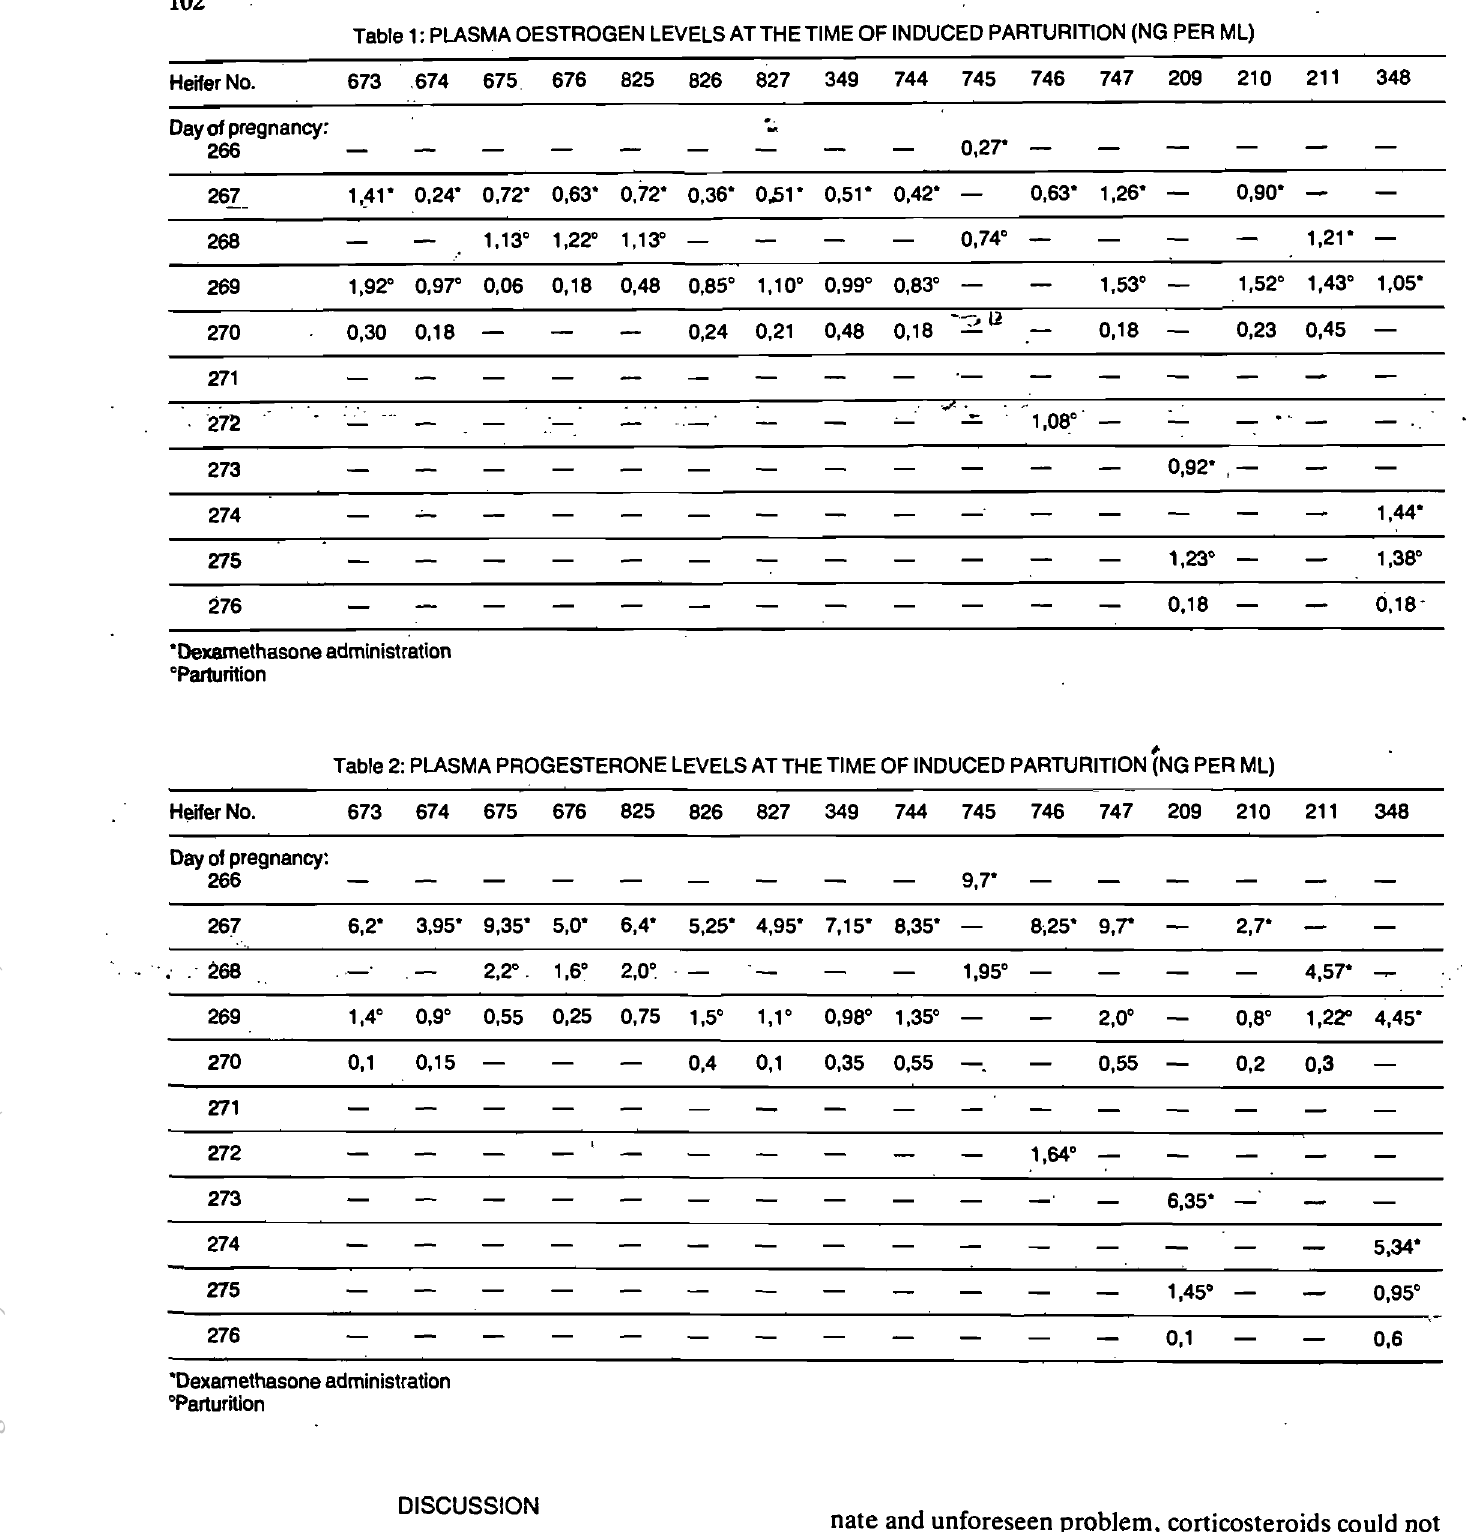
Table 1: PLASMA OESTROGEN LEVELS AT THE TIME OF INDUCED PARTURITION (NG PER ML) Heifer No.